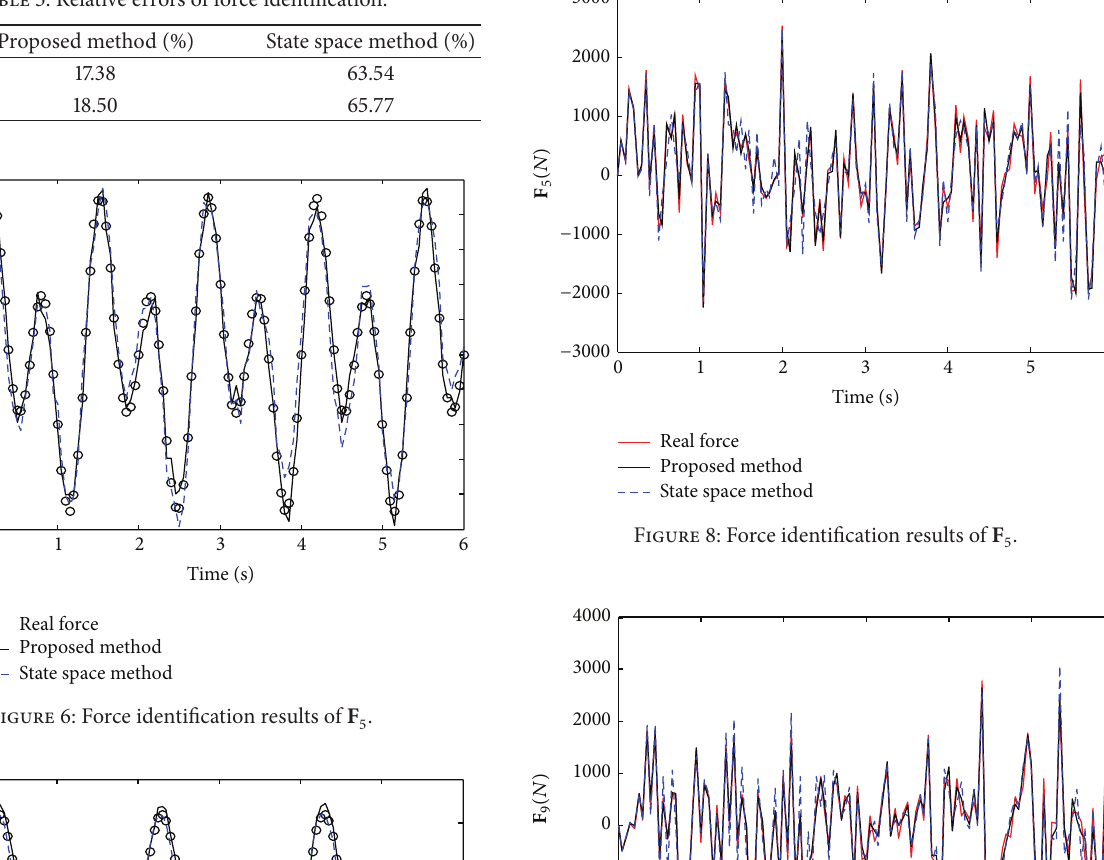
Table 5: Relative errors of force identification.